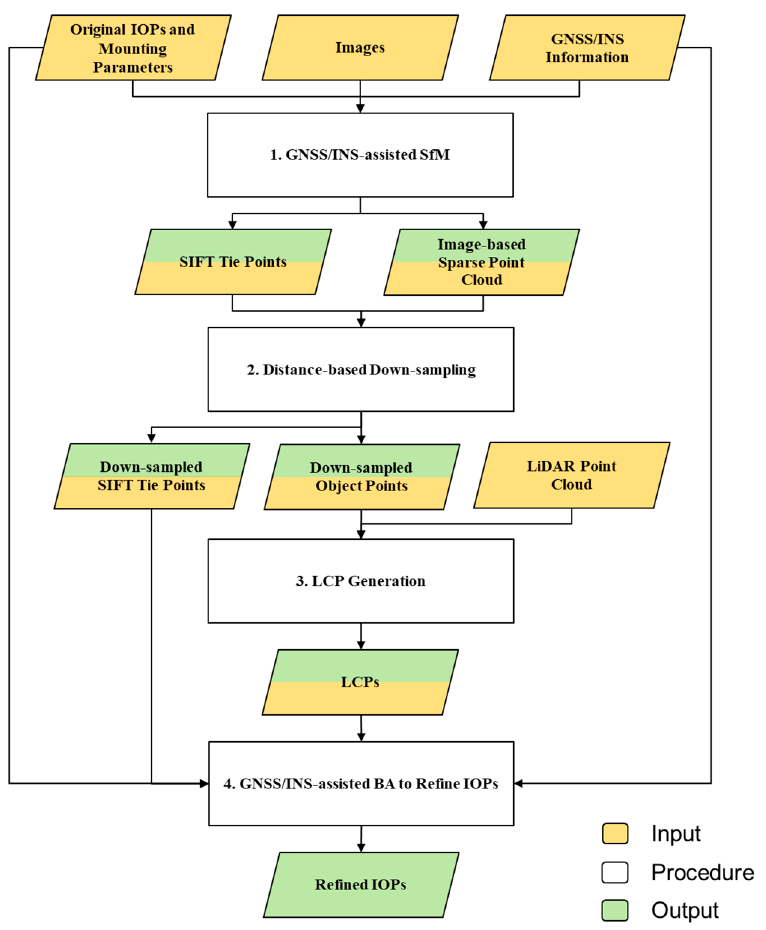
Figure 1. Flowchart of the proposed interior orientation parameters (IOP) refinement strategy.